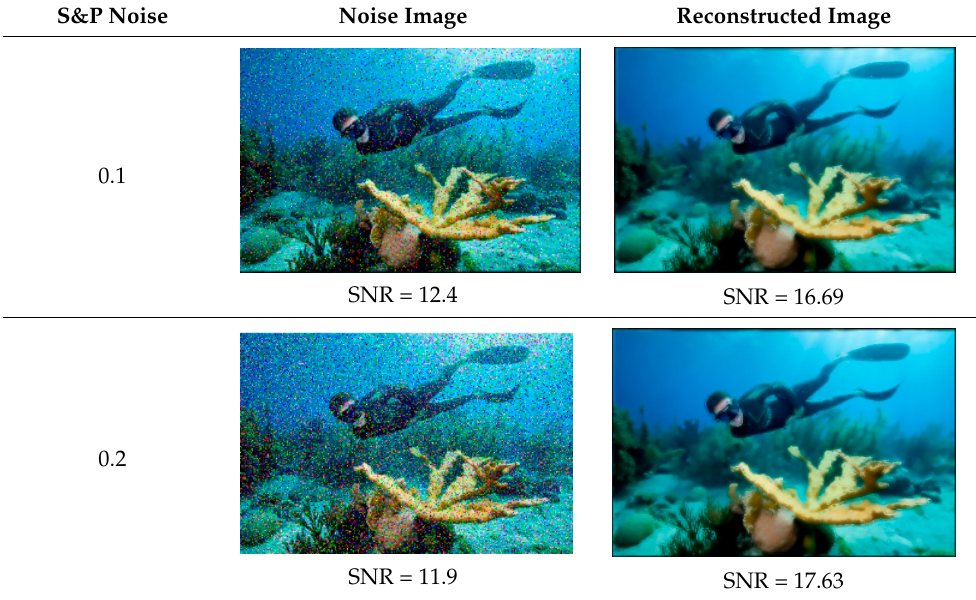
Table 4. Image Quality Reference.